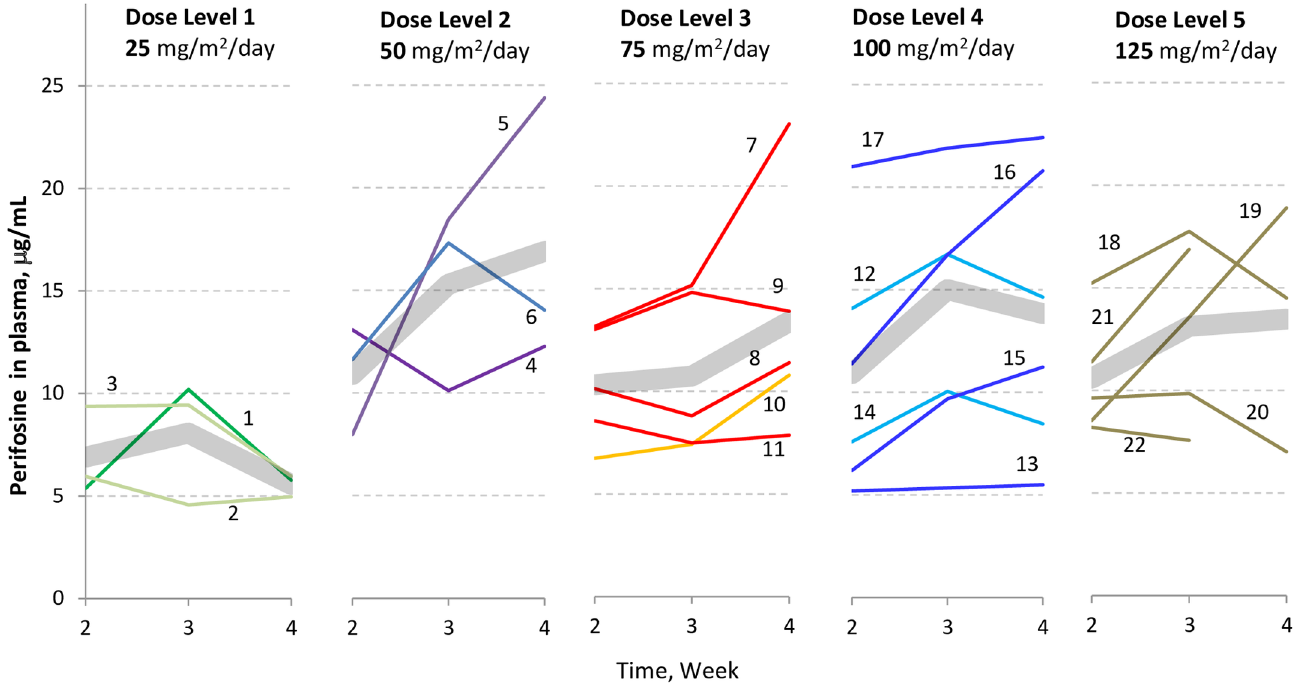
Fig 2. Steady state plasma concentration of perifosine at weeks 2, 3, and 4. Concentrations were plotted for each study subject whose samples were availablefor calculation(patients 1–22) across the dose groups; enumerated individualsubject trace; grey, semi-transparent thick line represents the arithmetic mean of the plasma concentration at the corresponding time-point for the given dose group. Saturabledose exposureabove 50 mg/m 2 / day dose is evident albeitlarge inter-patient variability, consistent with findings reportedin previous adult studies.